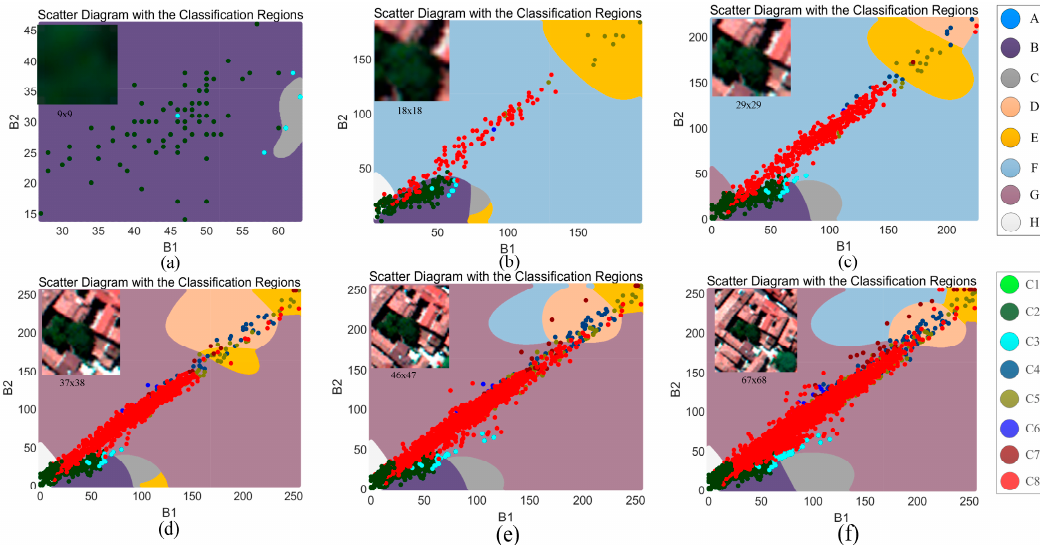
Figure 1. A demonstration to show the relationship between image content and its classified region using SVM, with an increase of candidate image spatial scale. From ( a ) to ( f ), the image size is 9 × 9, 18 × 18, 29 × 29, 37 × 38, 46 × 47, 67 × 68 pixels, respectively.